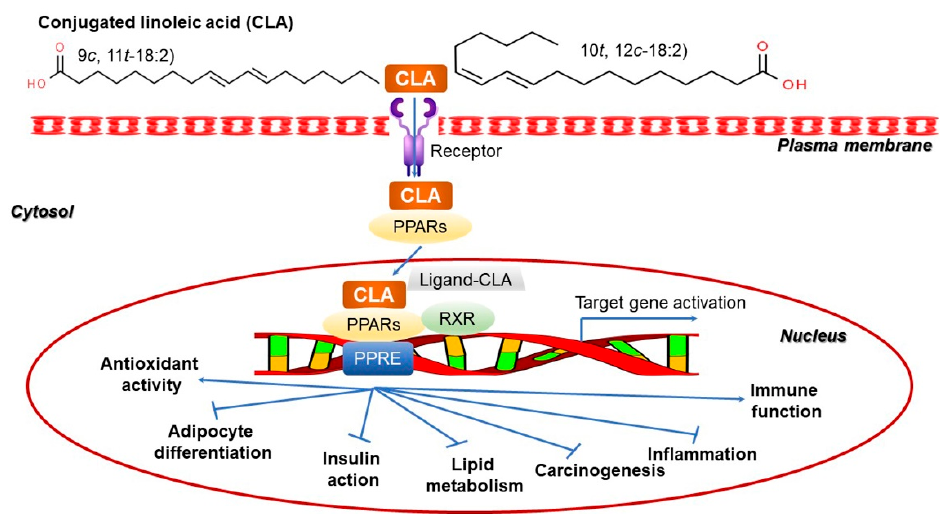
Figure 15. Schematic illustration of the CLA-regulated biological pathway during carcinogenic, adipose, diabetic, and cardiovascular diseases. CLA conjugated to nuclear receptors such as PPARs combines with a counterpart nuclear receptor named RXR to transcriptionally downregulate the target genes related to lipid metabolism including cellular differentiation of adipocytes, cancer cells, inflammatory cells, and pancreatic cells [184]. CLA, conjugated linoleic acid; PPAR, peroxisome proliferator-activated receptor; PPRE, peroxisome proliferator responsive element; RXR, retinoid X receptor. Figure adapted from Yang, B. et al. [184].